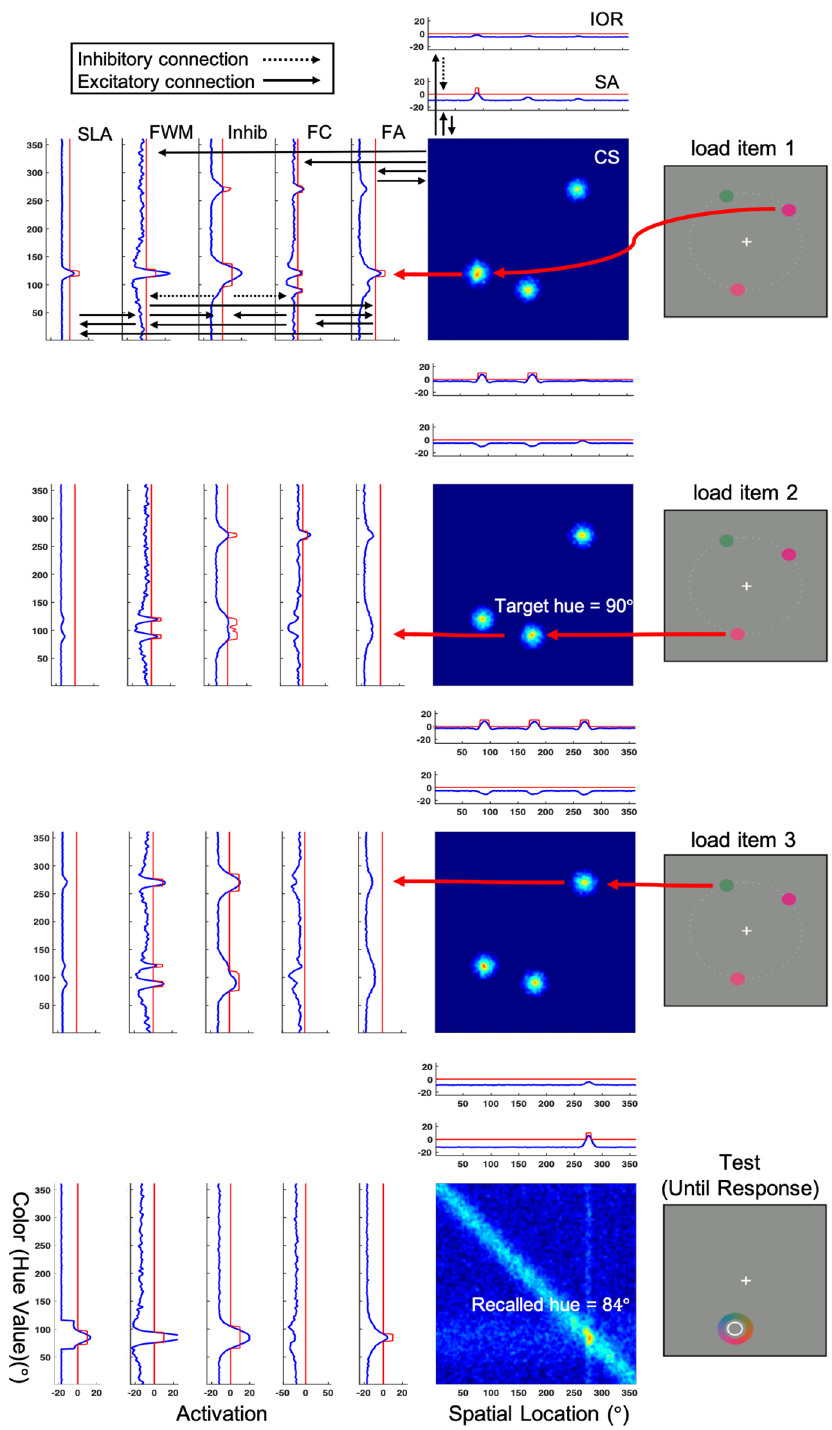
Figure 3. Model architecture and sample simulation of the simplified scene representation model used in Simulation Experiment 2 and the Control Simulations. This model includes an expanded spatial pathway that adds a spatial attention field (SA) and an Inhibition of Return (IOR) field, as well as a field representing attention at the scene level (SLA) to the model depicted in Fig. 1. These model additions give rise to an autonomous form of covert orienting that results in the sequential consolidation of items in WM, as shown in the top three panels of the figure. As before, blue lines represent the activation value across field sites, and red lines depict the sigmoidal threshold function. See the text for full details of the model simulation shown